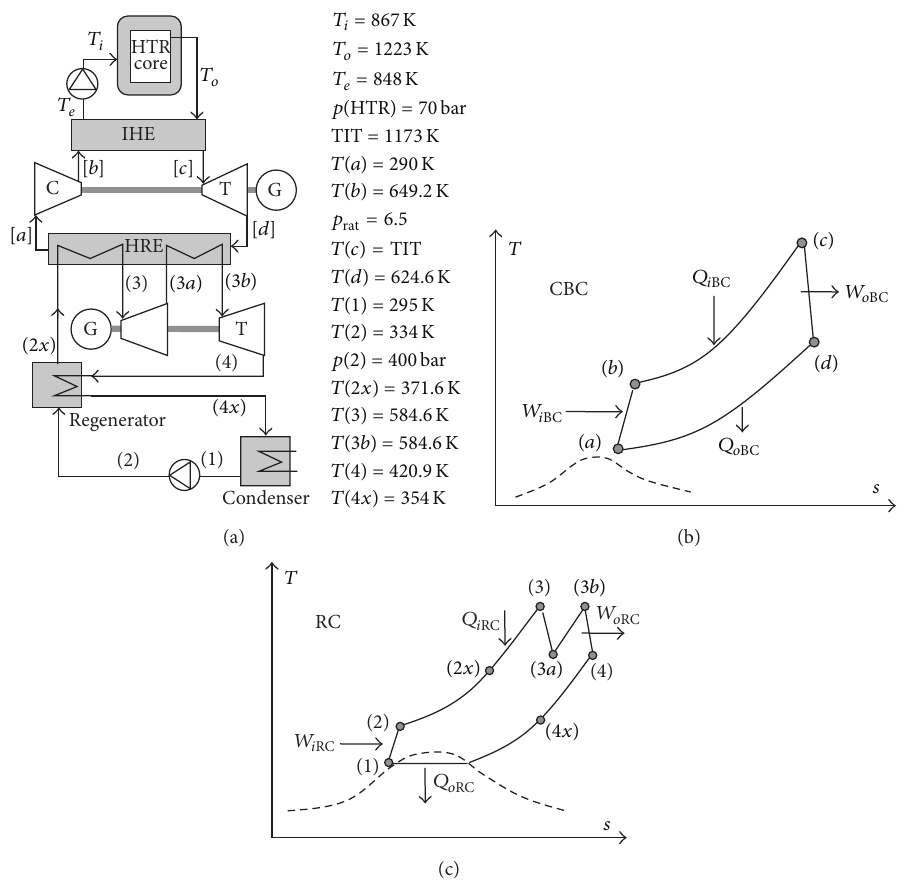
Figure 4: Diagram of the CC powered by helium cooled GT-MHR where the CBC operates with helium and the RC with carbon dioxide. combined cycles are relevant. Conventional pressure ratios in CBC are currently lower than 45, and depending mainly on the WF and the top cycle temperature, thermal efficiency can decrease even at very low pressure